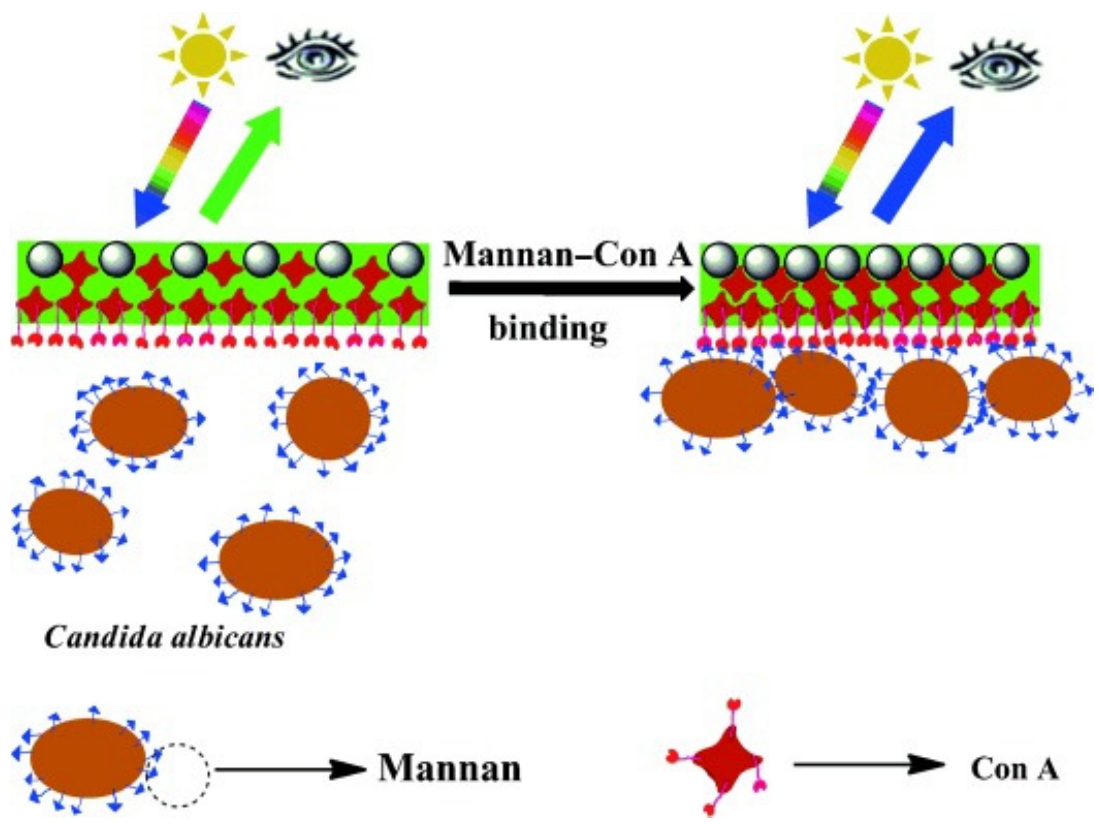
Figure 3. Schematic illustration of a sensor of mannans—a major surface carbohydrate of C. albicans . 2D photonic crystal (PC) arrays were synthesised using monodisperse polystyrene (PS) spheres. Thereafter, concanavalin A (Con A) mannose-binding lectin hydrogel was prepared by mild crosslinking of a Con A monomer solution with glutaraldehyde on the surface of the 2D PCs. The hydrogel Con A proteins each bind multiple mannose groups to surface-crosslink the protein hydrogel, resulting in shrinking and a decrease in the 2D array particle spacing that results in a blue-shift of the 2D array diffraction indicating the detection of mannans. Reprinted with permission from [130].